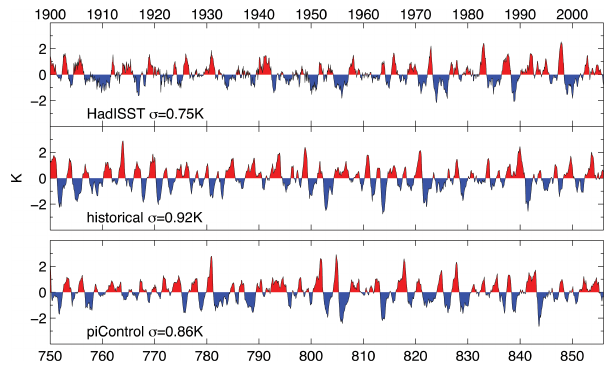
Fig. 16. Time series of detrended monthly SST anomalies of the NINO3.4 region (5 ◦ S–5 ◦ N; 170 ◦ W–120 ◦ W). The anomalies are found by subtracting the monthly means for the whole time series. Upper panel shows Hadley Centre Sea-Ice and Sea Surface Temperature data set (HadISST; Rayner et al., 2003), while middle and lower panel are Historical1 and piControl, respectively.